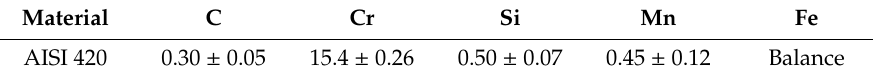
Table 1. Nominal chemical compositions of AISI 420